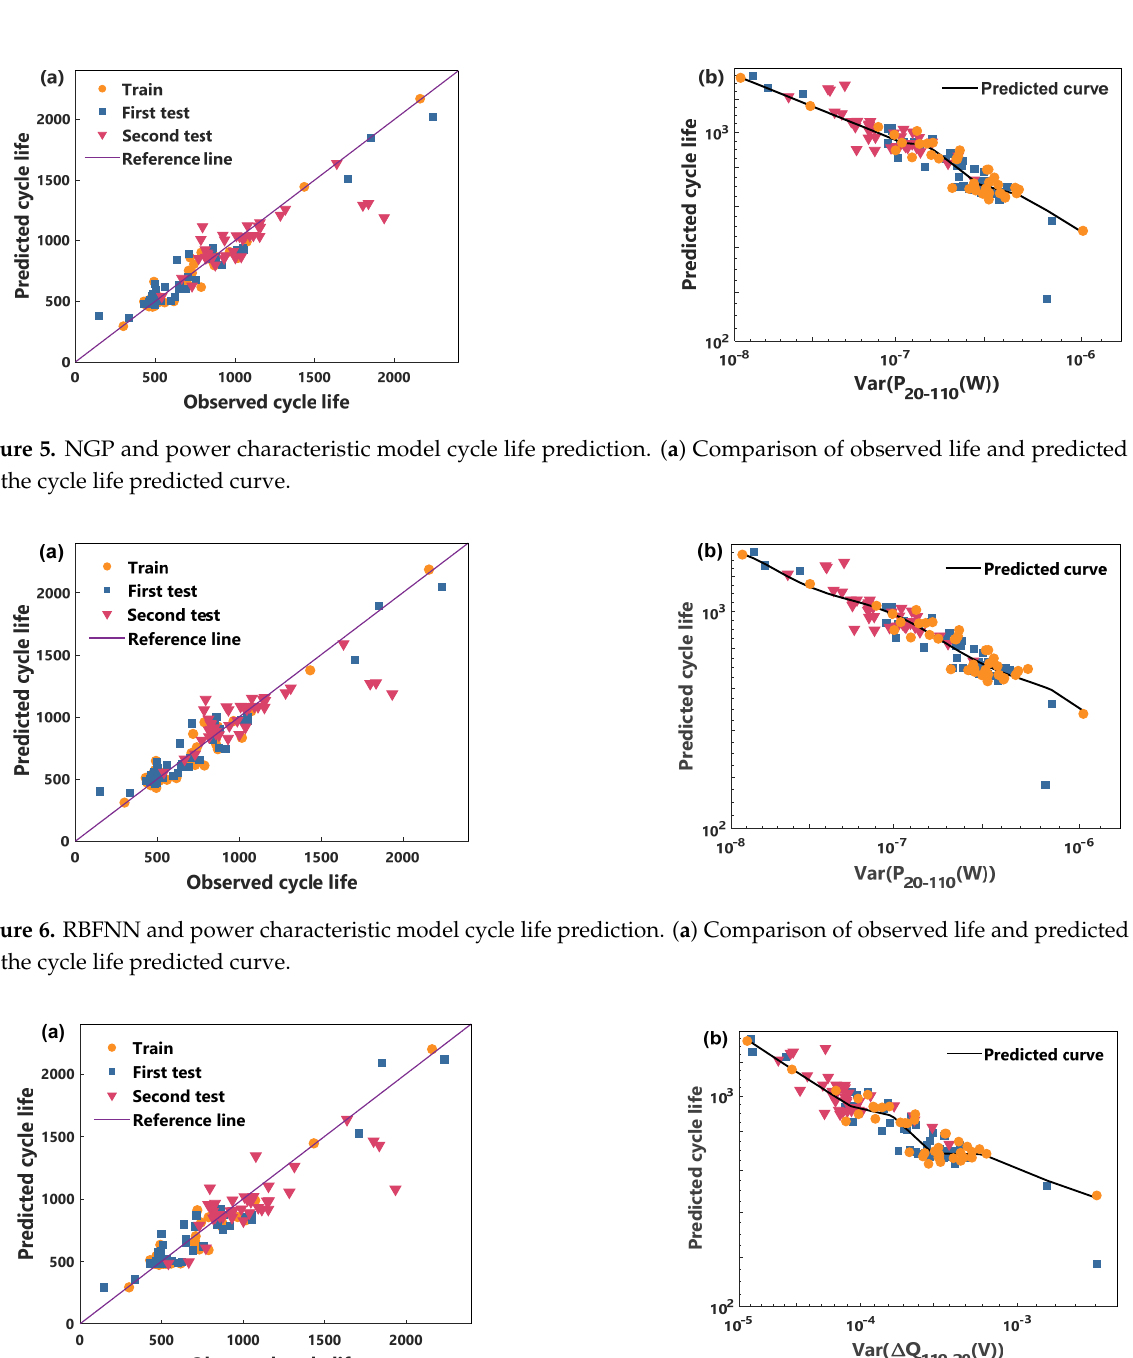
Figure 8. RBFNN and voltage characteristic model cycle life prediction. ( a ) Comparison of observed life and predicted life, ( b ) the cycle life predicted curve. Table 1. Comparison of battery cycle life prediction performance. Data Set MAPE of Model with Characteristics Power with NGP (%) Power with RBFNN (%) Voltage with NGP (%)